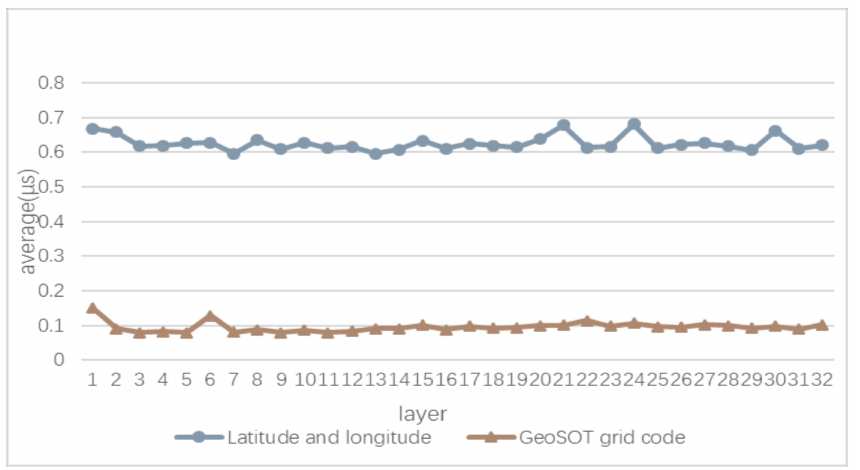
Figure 17. Average time for spatial orientation